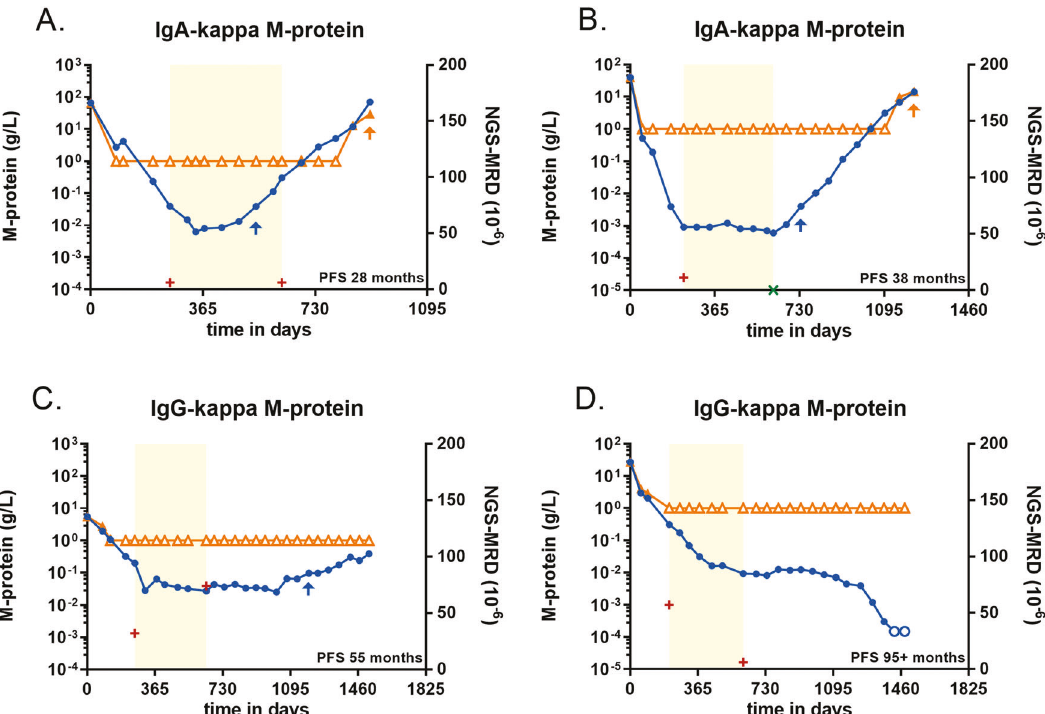
Fig. 1 Dynamic monitoring pro fi les in the IFM 2009 cohort. Open symbols indicate the analyte could not be detected. Orange triangles show SPEP data for the M-protein; blue dots show MS-MRD data. The yellow area indicates the period of maintenance treatment, with NGS- MRD assessments at the start and end. A positive NGS-MRD result is shown as a red plus; a negative NGS-MRD result as a green X. The blue arrow shows early evidence of progression based on MS-MRD data; the orange arrow shows where progression was seen in the data from the IFM 2009 study. A Patients with early progression during maintenance treatment. Patient 020001, IgA-kappa M-protein. B Patients with progression within one year after end of maintenance treatment. Patient 052003, IgA-kappa M-protein. C Patients with progression more than one year after end of maintenance treatment. Patient 044012, IgG-kappa M-protein. D Patients with no progression observed, this particular patient reached MS-MRD negativity after 1400 days of follow-up. Patient 025007, IgG-kappa